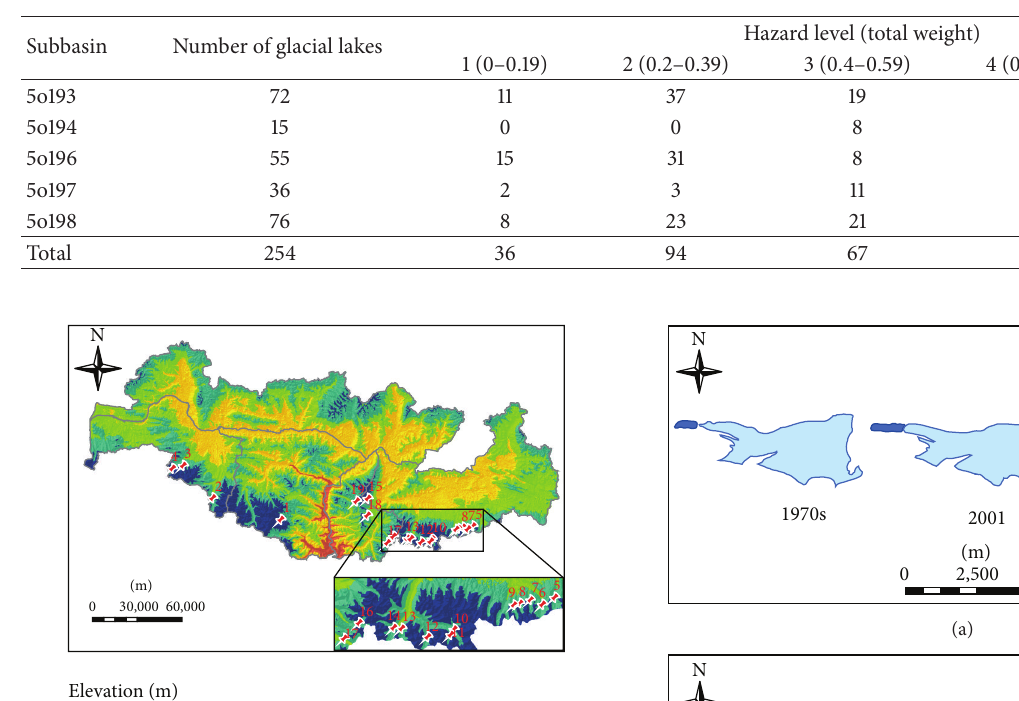
Table 4: Number of glacial lakes with different hazard levels in each subbasin.